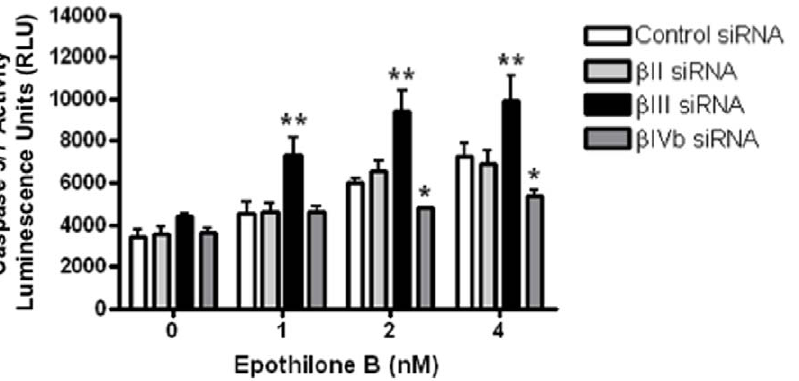
Figure 3. Caspase activity 3/7 assay. siRNA-transfected H460 cells were harvested after 24 h incubation in the presence or absence of epothilone B and subsequently assayed for apoptosis induction by caspase activity assay. Open bars: control siRNA-transfected cells; light grey solid bars: b II- tubulin knockdown cells; solid black bars: b III-tubulin knockdown cells; dark grey solid bars: b IVb-tubulin knockdown cells. Data represent means 6 SEM of at least three independent experiments. * P , 0.05; ** P , 0.01.